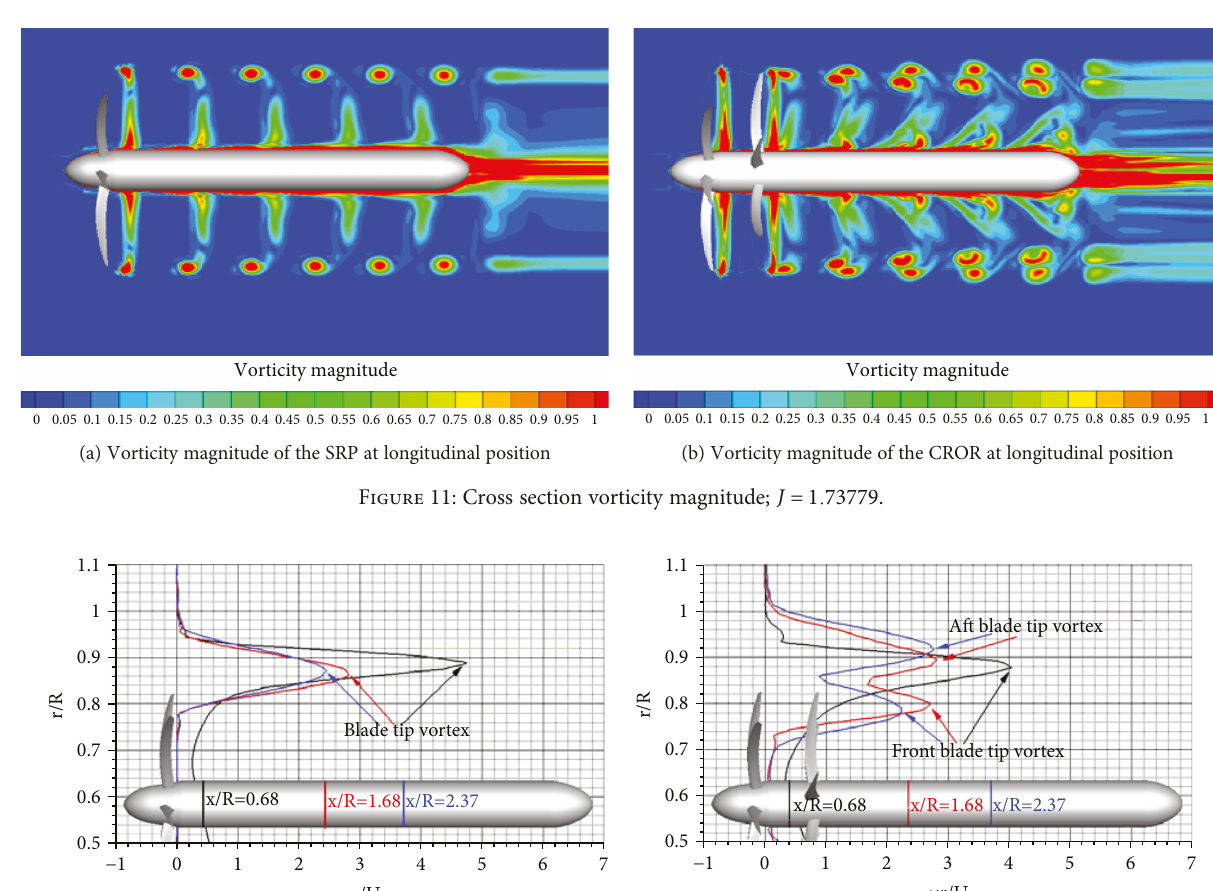
Figure 10: Slipstream fl ow fi eld; J = 1 73779